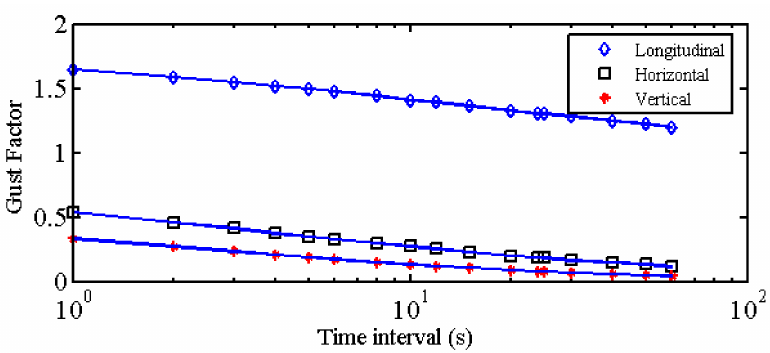
Figure 17. Gust factor at different time intervals.